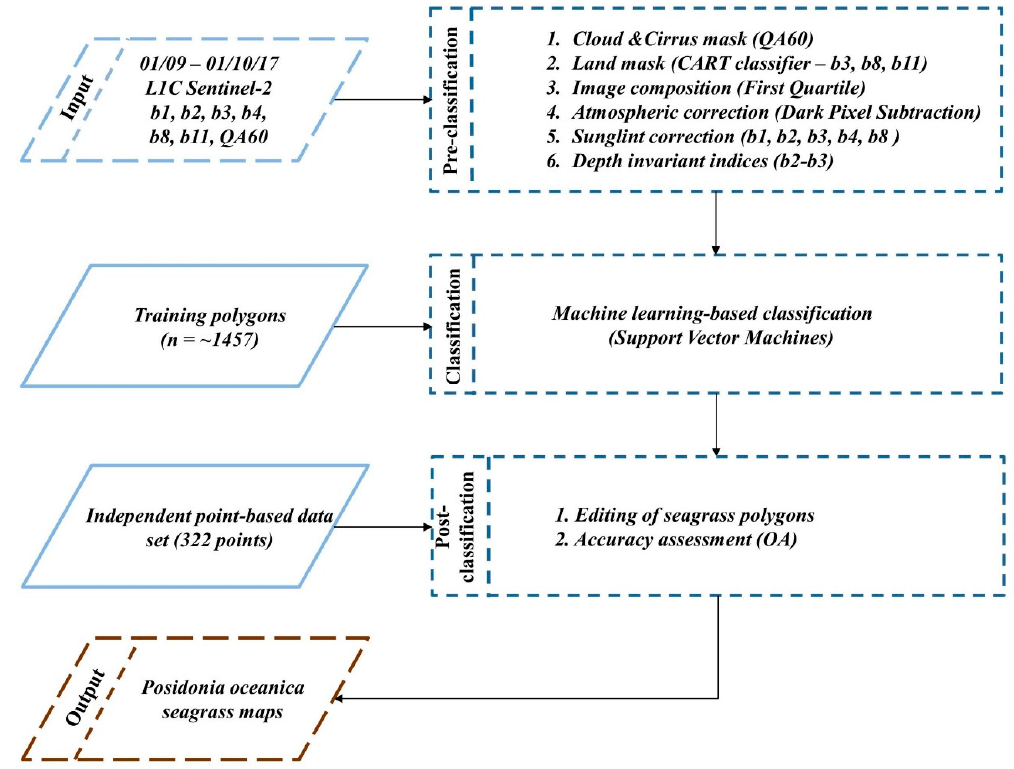
Figure 3. Methodological workflow of the present study within Google Earth Engine. OA denotes overall accuracy. In the present study we did not implement step 2 (due to the use of a coastline buffer), however, we include it as it is an important component of the methodological chain.